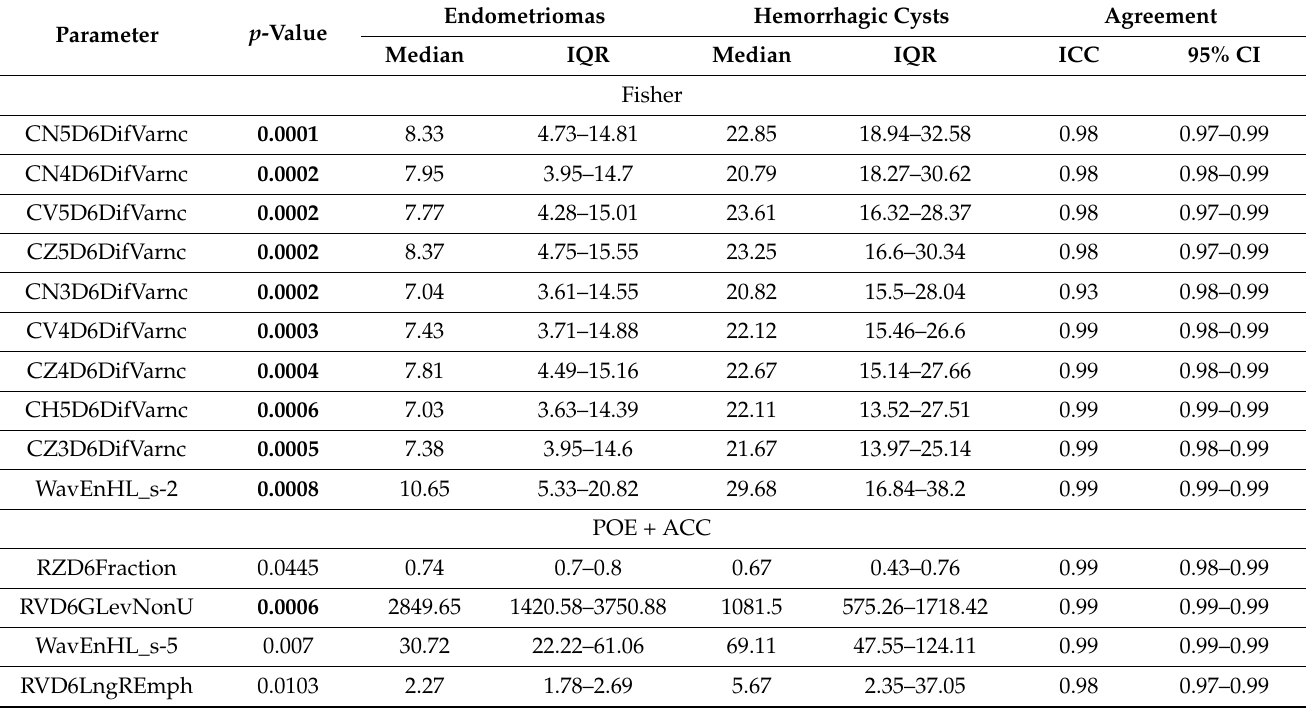
Table 4. The univariate analysis (Mann–Whitney U test) and the intra-reader agreement evaluation